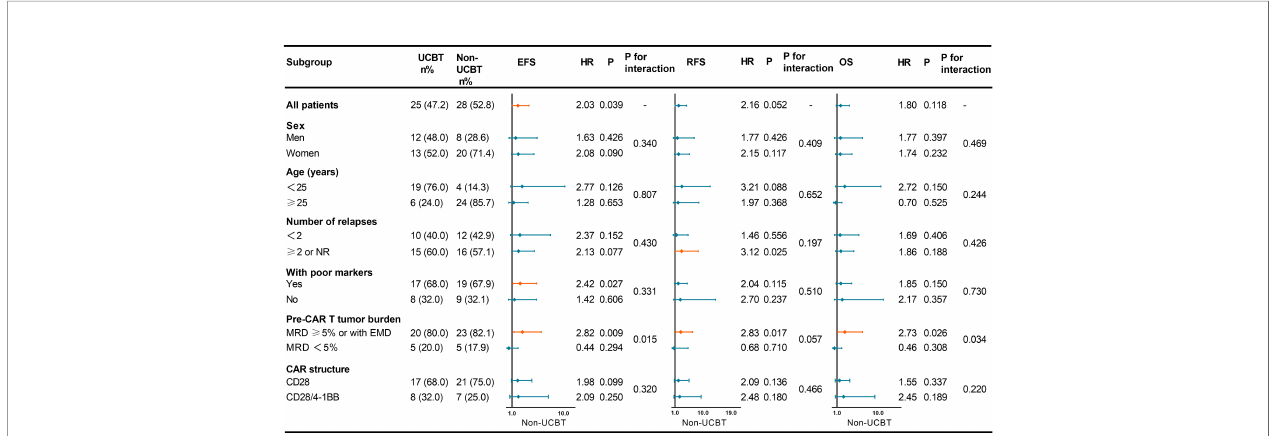
FIGURE 2 | Forest plot showing the hazard ratios for EFS, RFS, and OS of various subgroups. UCBT, unrelated cord blood transplantation; EFS, event-free survival; RFS, relapse-free survival; OS, overall survival; CAR, chimeric antigen receptor; NR, non-remission; MRD, minimal residual disease; EMD, extramedullary disease; HR, hazard ratio.